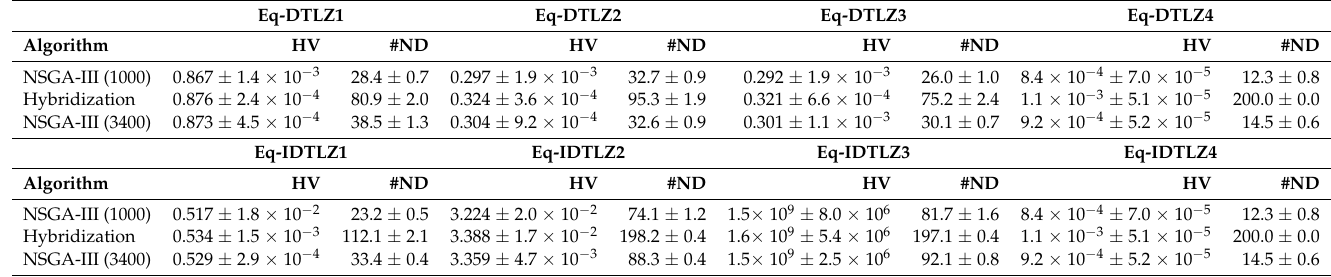
Table 3. On Eq-DTLZ1-4 and Eq-IDTLZ1-4 problems, the sample mean and standard error of the hypervolume (HV) value and the number of final non-dominated (ND) points over 15 independent runs for each algorithm. The hypervolume values are computed with reference point ( 1,1,1 ) (cid:62) for all problems except Eq-DTLZ4, Eq-IDTLZ3, and Eq-IDTLZ4, which we use ( 1.2,5 ( 800,800,700 ) (cid:62) , and ( 0.4,0.6,0.6 ) (cid:62) , respectively. The initial population is µ = 200 for all algorithms. − Hybridization = NSGA-III (iter = 1000) + HVN (iter = 10), which consumes roughly the same